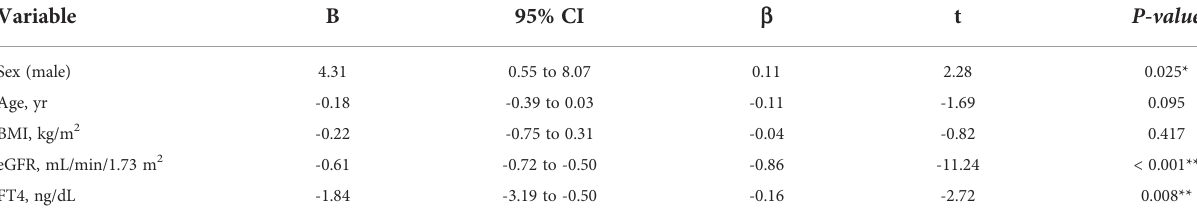
TABLE 3B Adjusted for sex, age, BMI, eGFR and FT4.